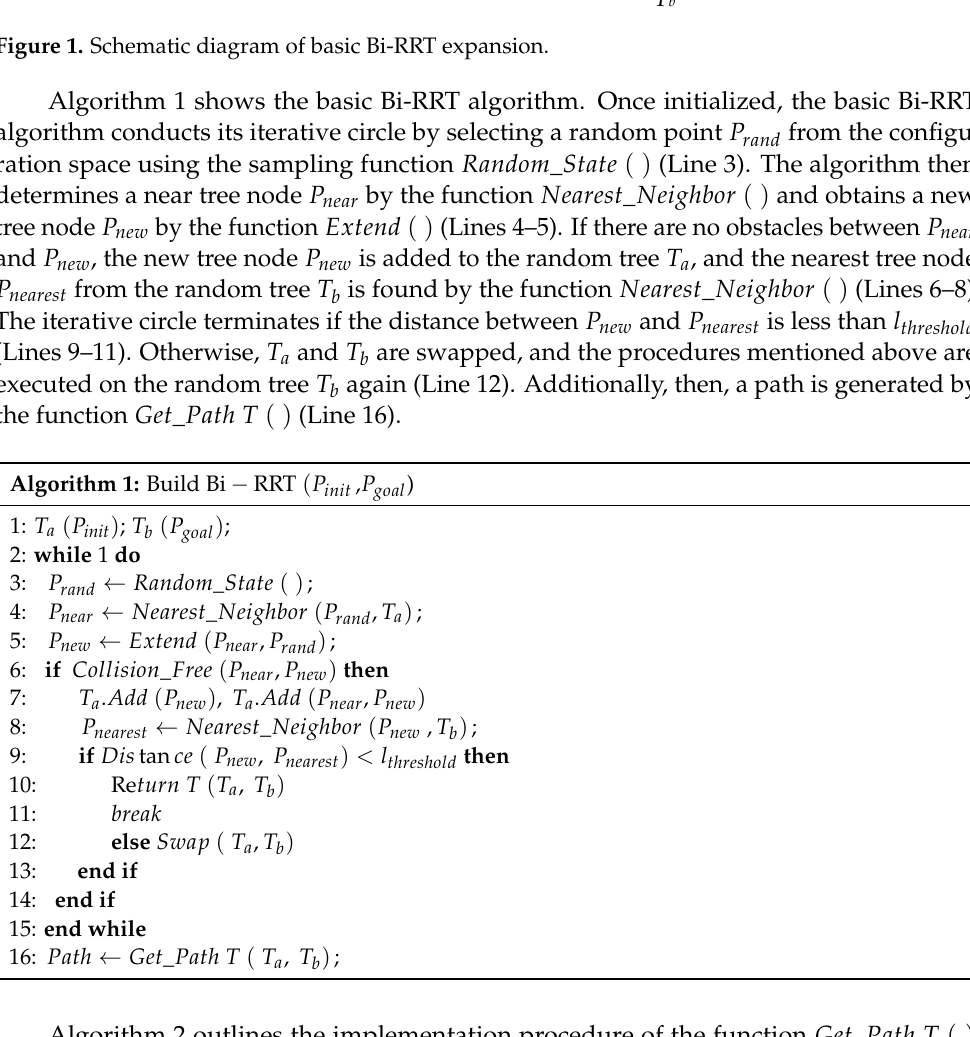
Algorithm 2 outlines the implementation procedure of the function Get _ Path T ( )